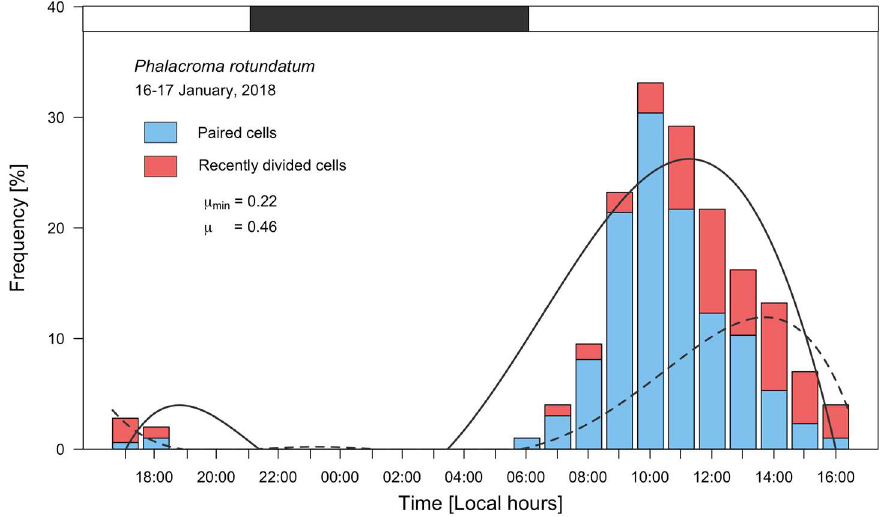
Figure 5. Distribution of frequencies of vegetative paired (blue bars) and recently divided cells (red bars) of P. rotundatum from 16 to 17 January 2018, fitted to a 5 th degree polynomial curve. The solid line curve corresponds to paired cells, and the dashed line to recently divided cells; the black segment in top bar indicates the dark (sunset to sunrise) period.